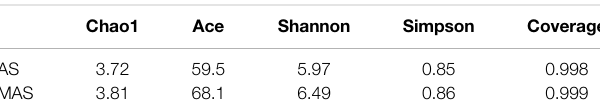
TABLE 1 | Diversity index of two